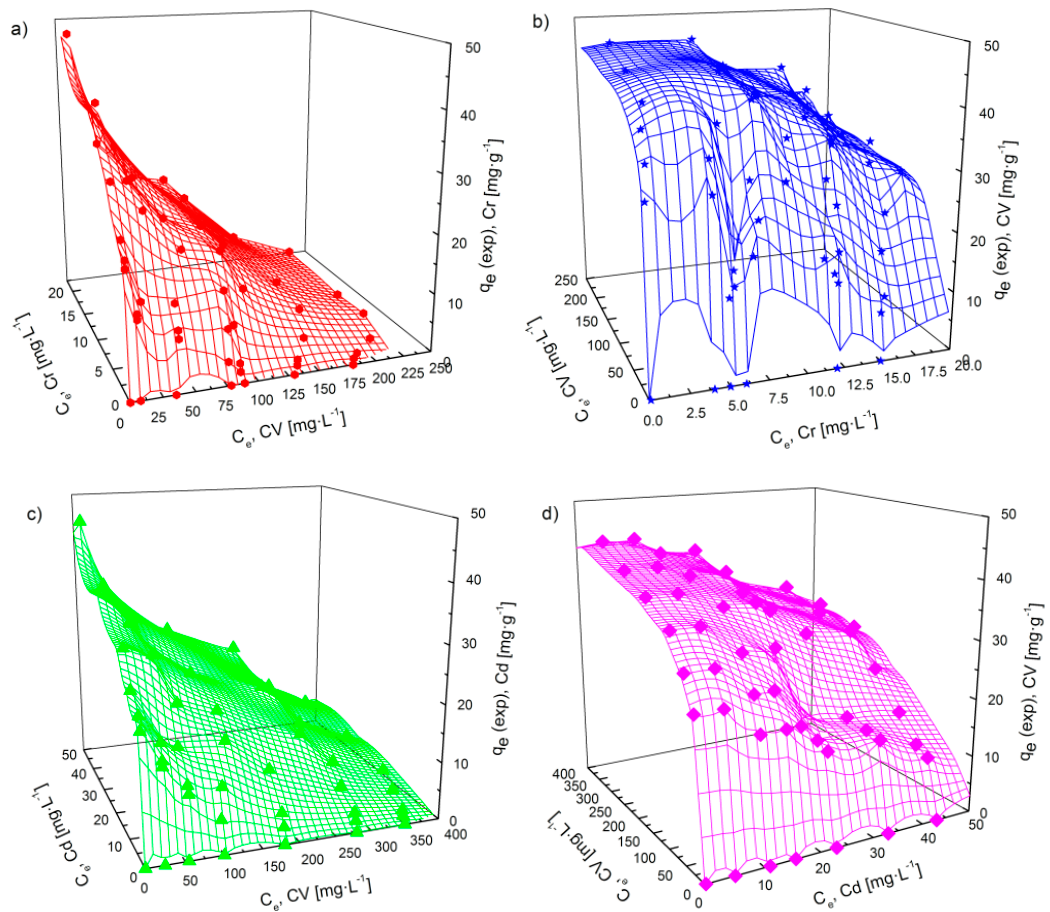
Figure 11. Forecast of surfaces by the EL model: ( a ) qe (exp) Cr(III) in the Cr(III)–CV system, ( b ) qe (exp) CV in the Cr(III)–CV system, ( c ) qe (exp) Cd(II) in the Cd(II)–CV system, and ( d ) qe (exp) CV in the Cd(II)–CV system.